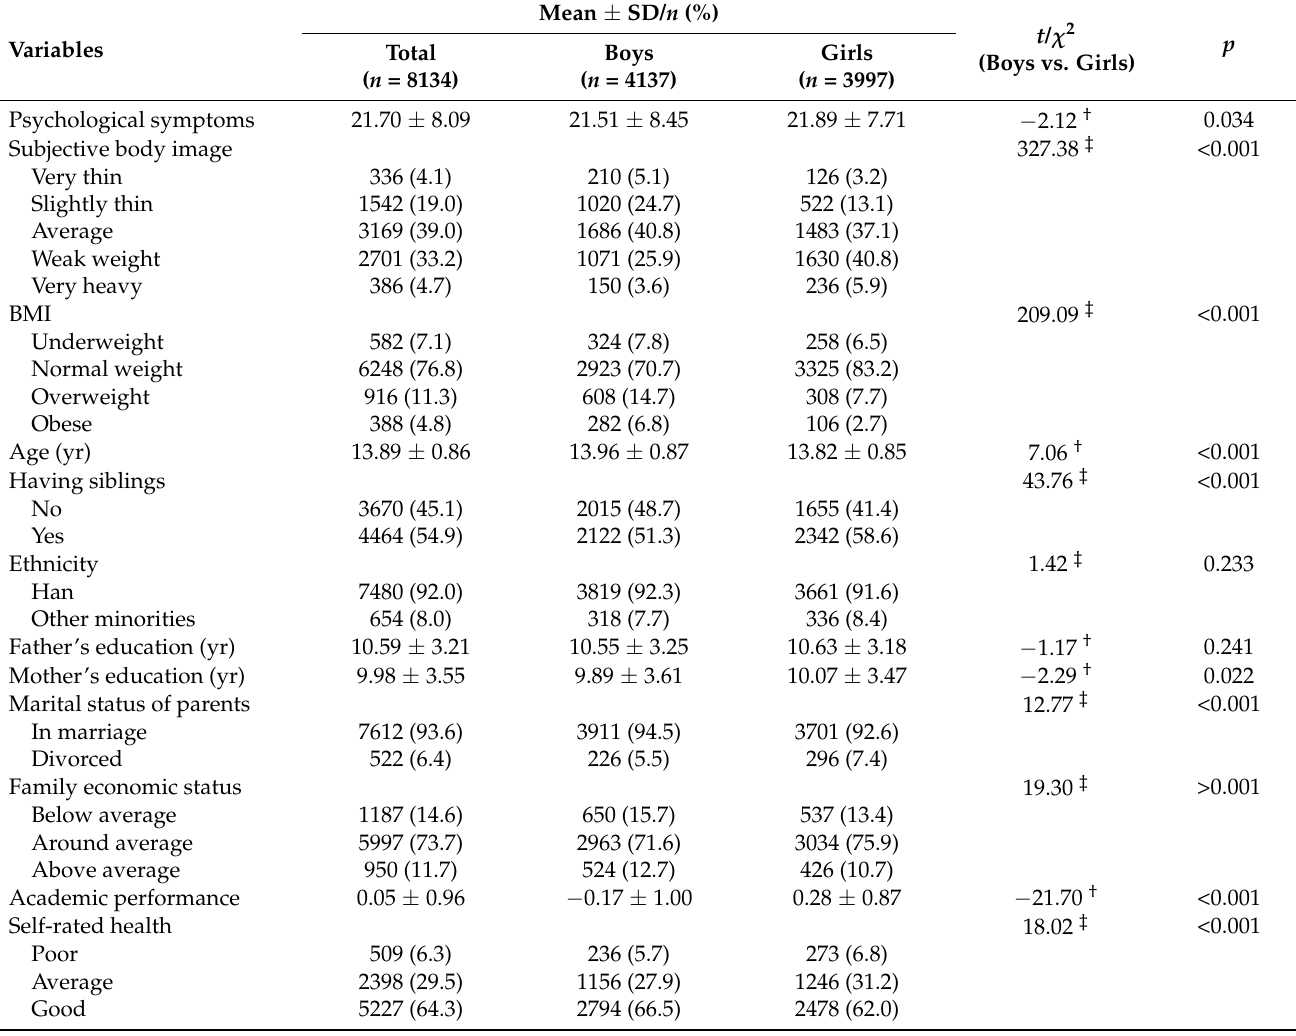
Table 1. Descriptive statistics for the total sample and the two gender-specific